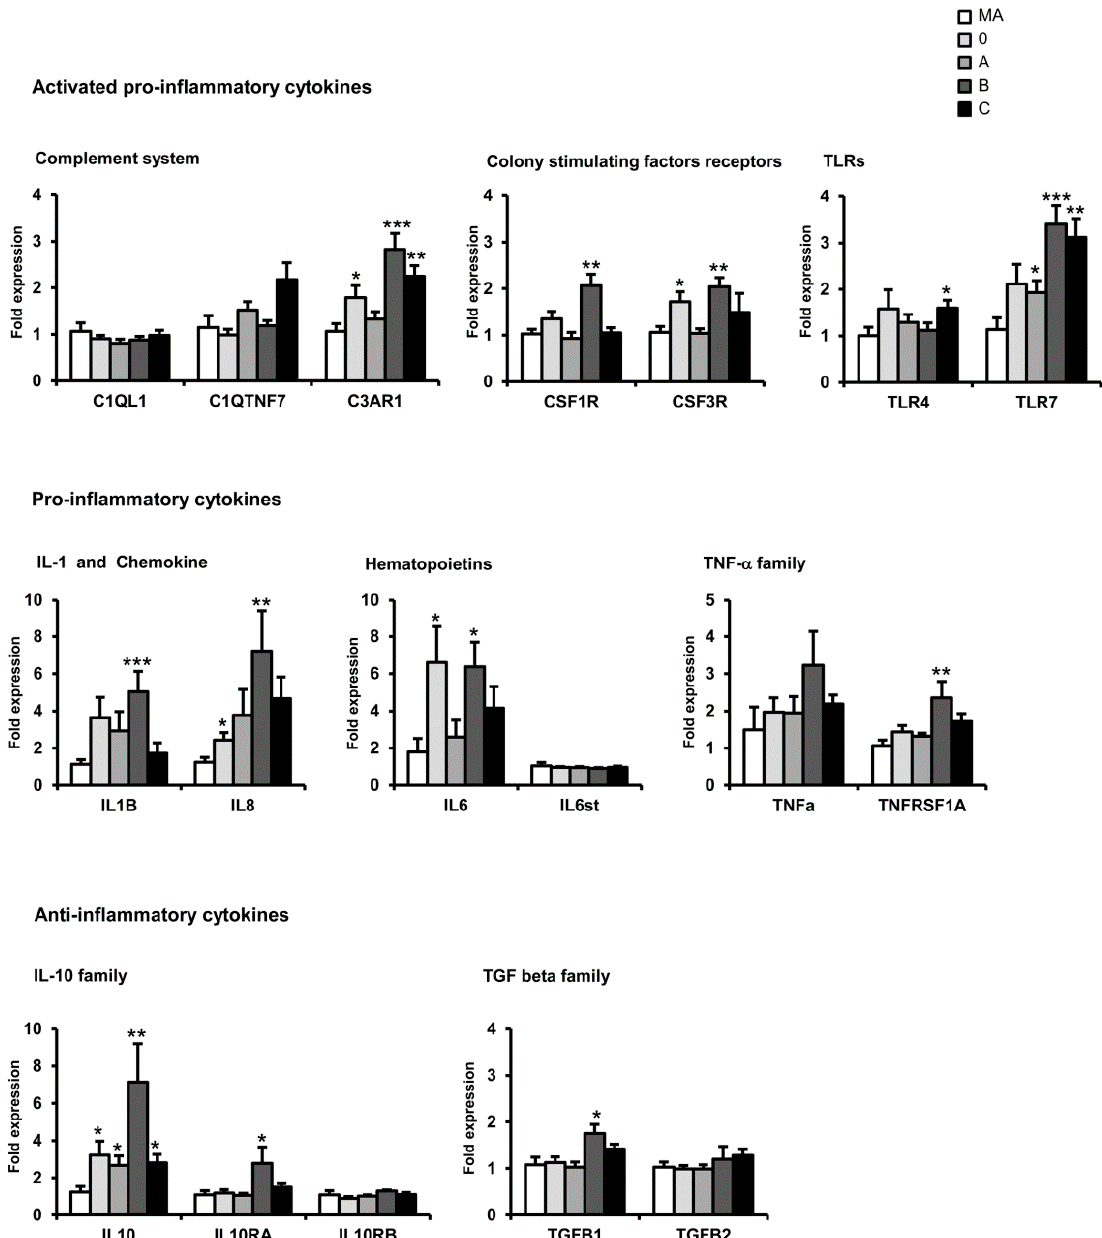
Figure 1. mRNA expression of selected cytokines and mediators of the immune response in the entorhinal cortex in AD cases at stages 0, A, B, and C according to the CERAD semi-quantitative assessment of neuritic plaques. Data are represented as the mean ± SEM * p < 0.05, ** p < 001, *** p < 0.001 (see Ref. [177] for details).